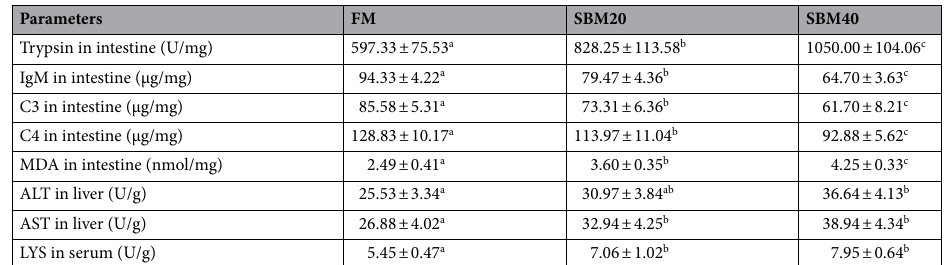
Table 3. Effect of soybean meal on the enzyme activities of pearl gentian grouper (n = 3).